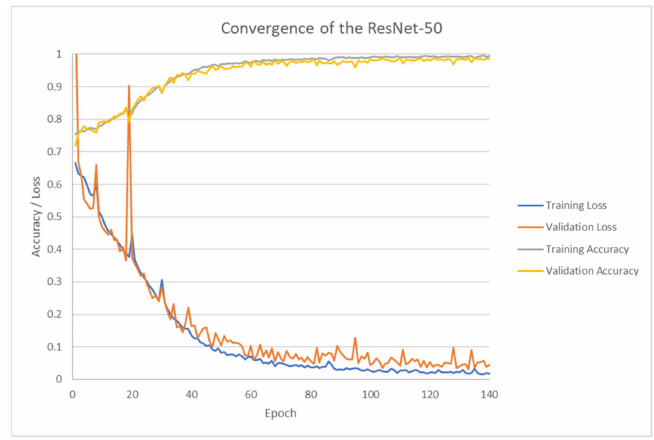
Figure 9. Classification accuracy versus